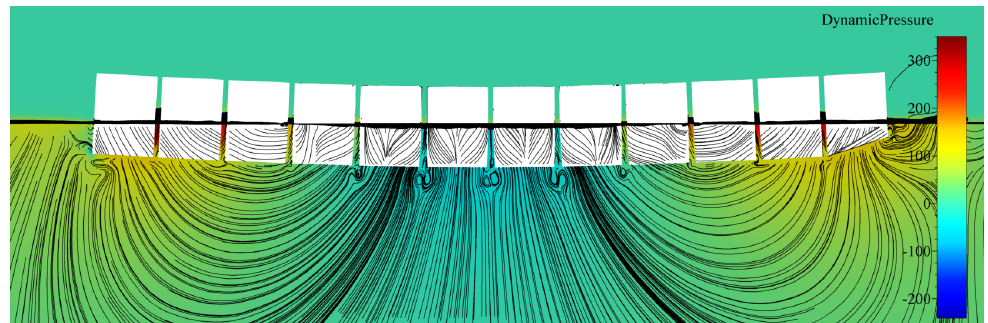
Figure 9. Section cut at the centreline, showing streamlines and the dynamic pressure field for the first mode of vertical vibration of the segmented